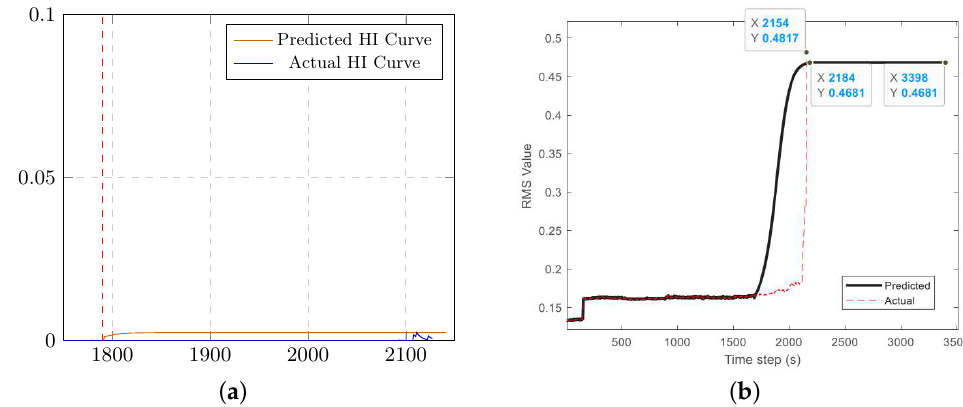
Figure 8. Inner race failure RUL prediction. ( a ) Proposed model. ( b ) Presented model at [58], reprinted with permission from Ref. [58], Copyright 2021,